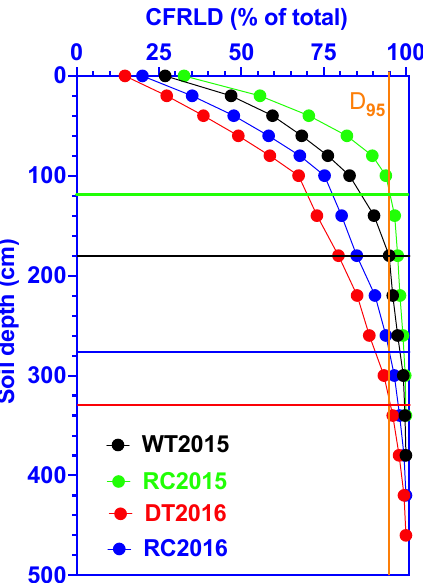
Figure 4. Vertical distribution (0–5 m, A ) and content ( B ) of fine-root length density (FRLD, cm/dm 3 ) in a wet year of higher-than-average rainfall (2015) and a dry year of lower-than-average rainfall (2016) in Robinia pseudoacacia forest stands of different treatments. Different letters indicate a statistically significant difference at p < 0.05 between treatments. Error bars represent ±1 SD. WT2015 is wet year of 2015 without in situ rainwater collection and infiltration system; RC2015 is wet year of 2015 with in situ rainwater collection and infiltration system; DT2016 is dry year of 2016 without in situ rainwater collection and infiltration system and RC2016 is wet year of 2016 with in situ rainwater collection and infiltration system.